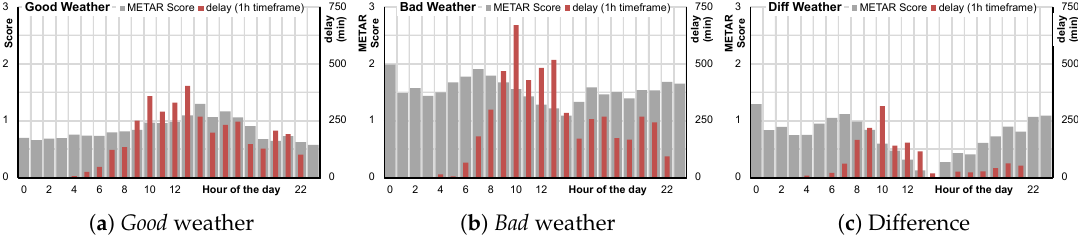
Figure 9. Categorization of weather days, separated by the specific ATMAP score of 2.7 to distinguish between ( a ) good and ( b ) bad weather conditions; ( c ) indicates the differences